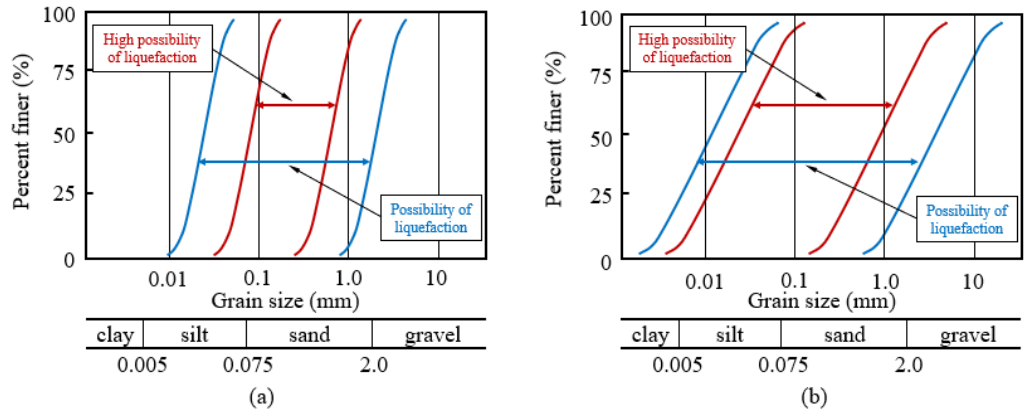
Figure 1. Grain size distribution curve boundaries for the possibility of liquefaction: ( a ) soil with low coefficient of uniformity; ( b ) soil with high coefficient of uniformity (modified from [20] ).